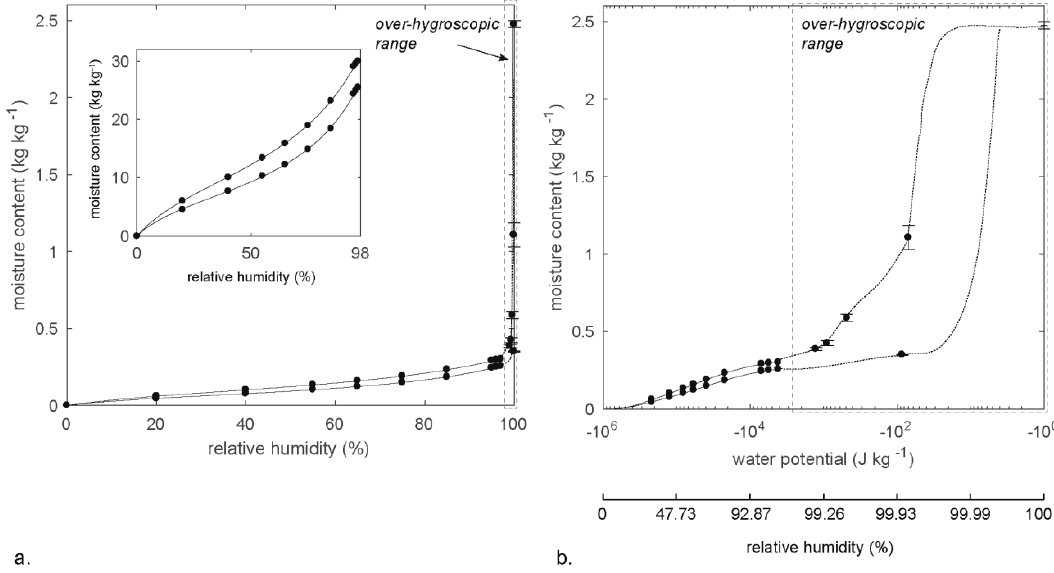
Figure 1. Sorption isotherms for Norway spruce ( Picea abies (L.) Karst.) as a function of relative humidity ( a ) and water potential ( b ); data from Fredriksson and Johansson [25]. The insert in (a) shows the hygroscopic part of the sorption isotherm. Note that, in (b), the moisture content at − 100 J · kg − 1 is the moisture content at water saturation, and the shape of the over-hygroscopic part of the sorption isotherm is an estimation based on the structure of spruce.